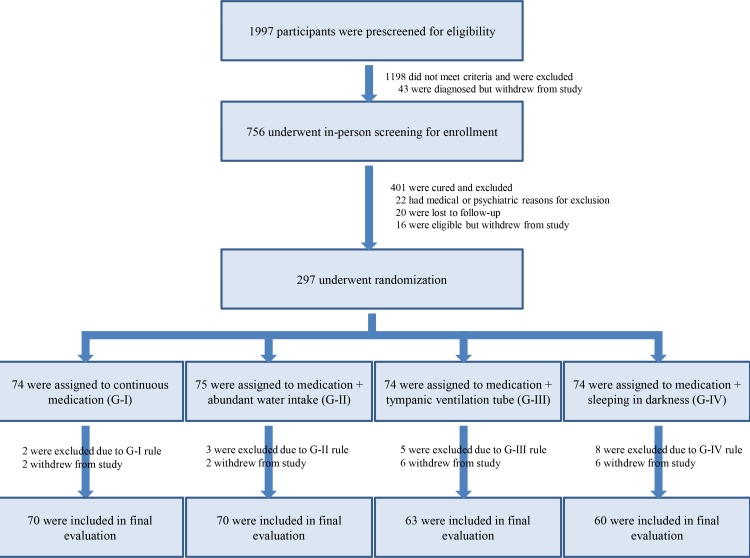
Flow chart of the present randomized controlled study.